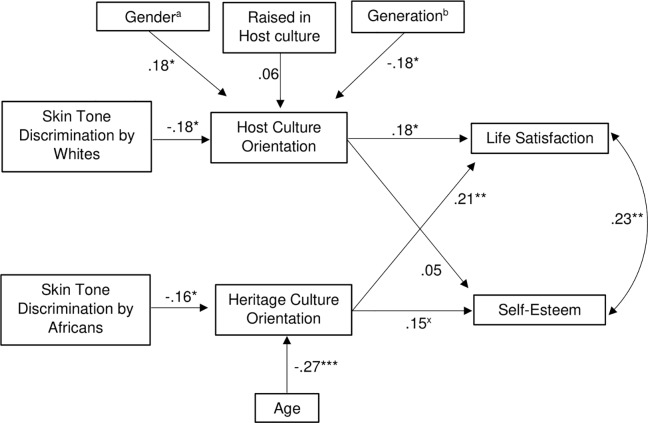
Path model.acoded as 0 = female, 1 = male. bcoded as 0 = first generation, 1 = second generation. xp = .053, *p < .05, **p < .01, ***p < .001.